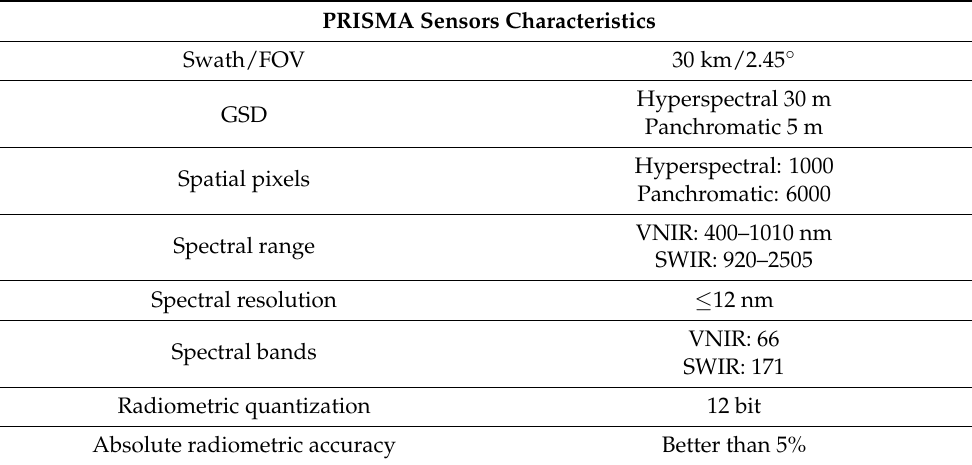
Table 2. Prisma hyperspectral and panchromatic sensors specifications. Modified after